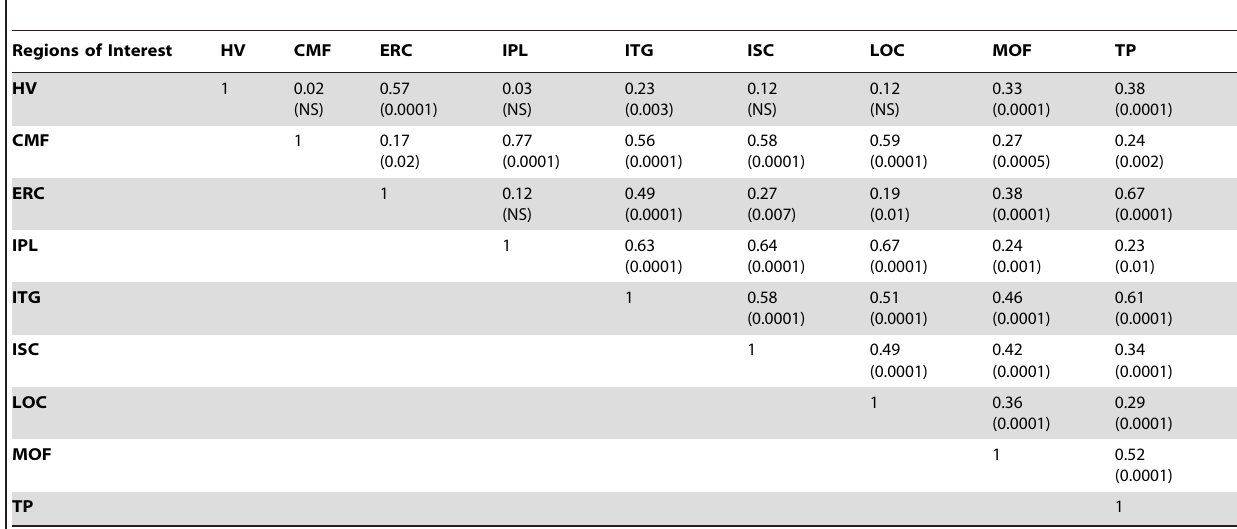
individual ROIs and total hippocampal volume. Separate linear regression models were constructed for the amyloid positive, amyloid negative, p-tau positive and p-tau negative MCI and AD individuals, with the baseline thickness of the individual ROIs as predictors for hippocampal atrophy rate. Logistic regression models and multivariate analysis of variance (MANOVA) were used to compare whether baseline thickness of the individual ROIs significantly differentiated amyloid positive from amyloid negative Table 3. Correlation results between cortical thickness of eight neocortical ROIs and total hippocampal volume in only AD individuals